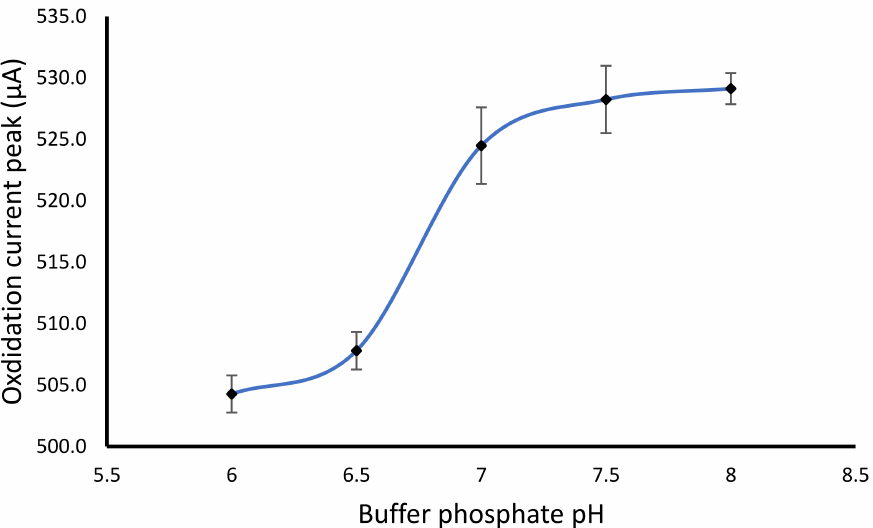
Figure 5. Effect of buffer pH on the hydrogen peroxide oxidation peak using the modified alginate- NiFe 2 O 4 nanoparticles cryogel